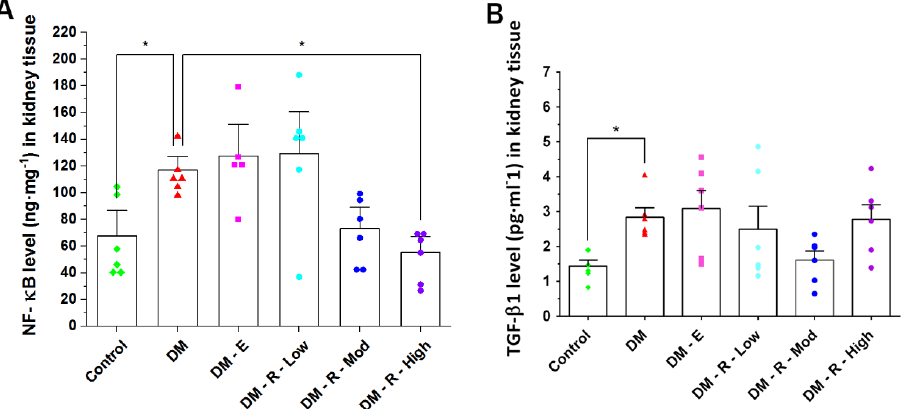
Figure 2. Effect of ruxolitinib on kidney NF- κ B ( A ) and TGF- β 1 ( B ) levels. ( A ) NF- κ B level in kidney tissue homogenates of normal (control) rats and ( B )TGF- β 1 level in kidney tissue homogenates of normal (control), diabetic treated, and diabetic non-treated male Wistar rats. DM, diabetic non-treated group, DM-E, diabetic enalapril-treated group (10 mg · kg − 1 ), DM-R-Low, diabetic ruxolitinib-treated low-dose group (0.44 mg · kg − 1 ), DM-R-Mod; diabetic ruxolitinib-treated moderate-dose group (2.2 mg · kg − 1 ), DM-R-High, diabetic ruxolitinib-treated high-dose group (4.4 mg · kg − 1 ). Each column represents the mean ( ± S.E.M.) for 6 male Wistar rats. Data are represented as individual values for each mouse (dots). Statistical significance is shown by asterisks (* p < 0.05). The difference among groups was assessed by the Kruskal–Wallis test followed by the Mann-Whitney U test for post hoc group binary comparisons.